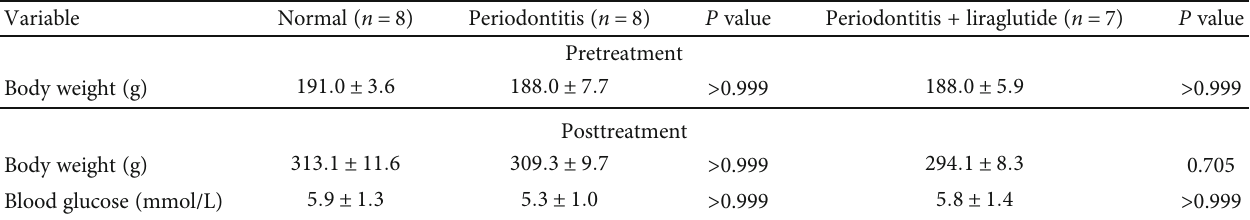
Table 1: Body weights and blood glucose levels in normal, periodontitis, and liraglutide-treated periodontitis rats. Variable